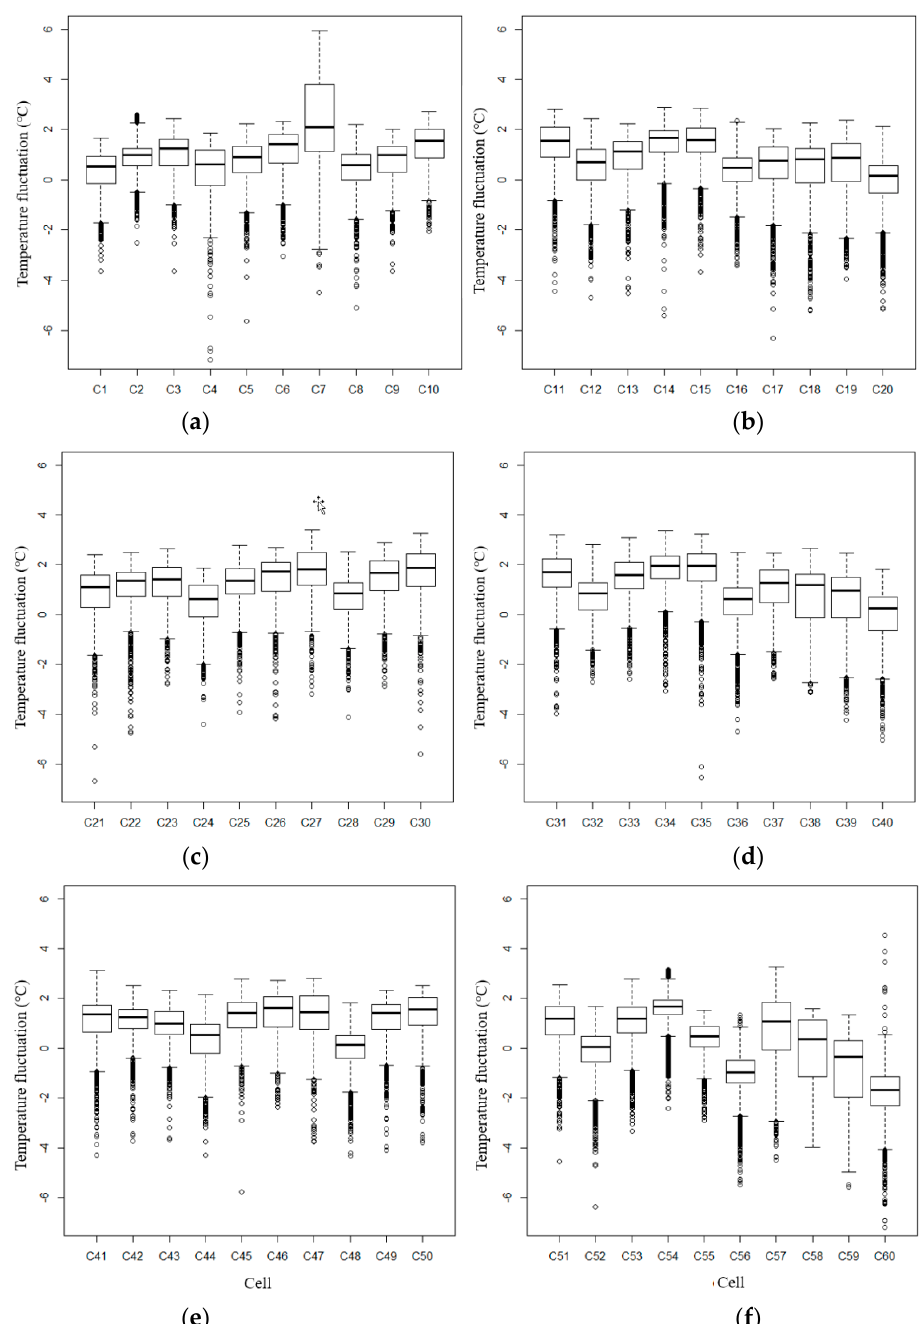
Figure 11. Analysis of variation characteristics of solar cell temperature by boxplot. ( a ) Temperature statistics for cell numbers C1 to C10; ( b ) Cell numbers C11 to C20; ( c ) Cell numbers C21 to C30; ( d ) Cell numbers C31 to C40; ( e ) Cell numbers C41 to C50; ( f ) Cell numbers C51 to C60.